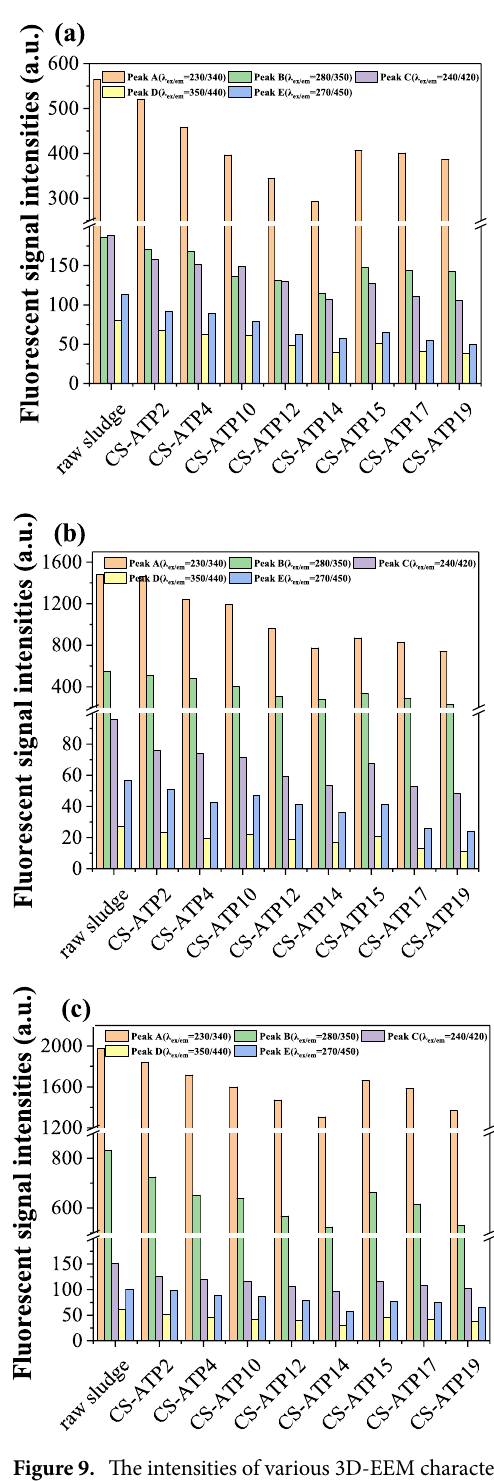
Figure 9. The intensities of various 3D-EEM characteristic peaks of ( a ) S-EPS, ( b ) LB-EPS and ( c ) TB-EPS in sludge conditioned by St-CTA in conjunction with ATP using different